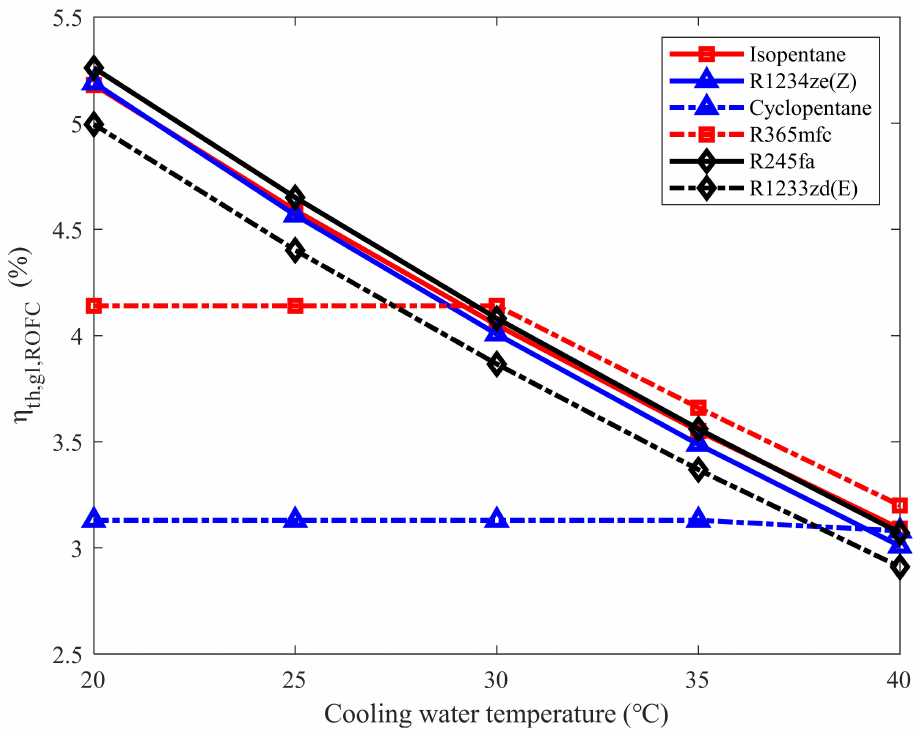
Figure 14. Effect of the cooling water temperature on the global thermal